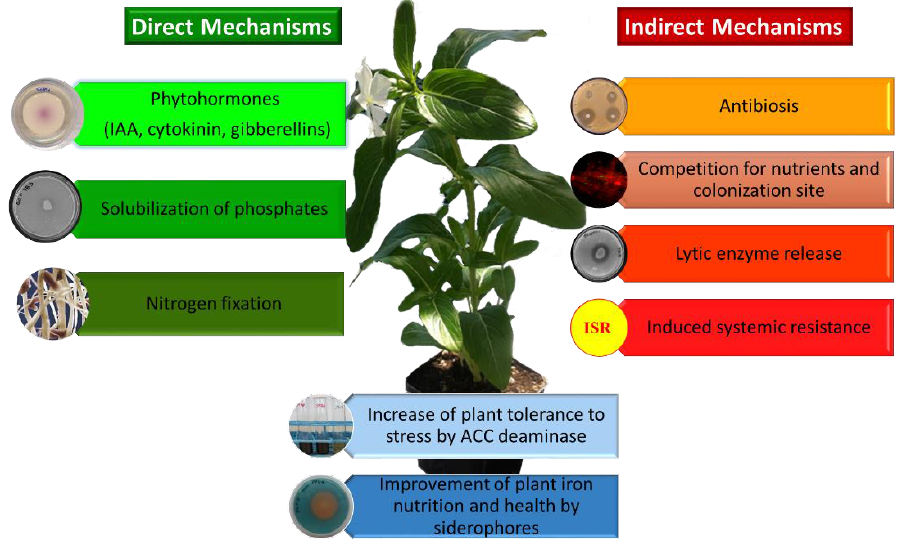
Figure 2. Mechanisms used by PGPB to improve plant growth and